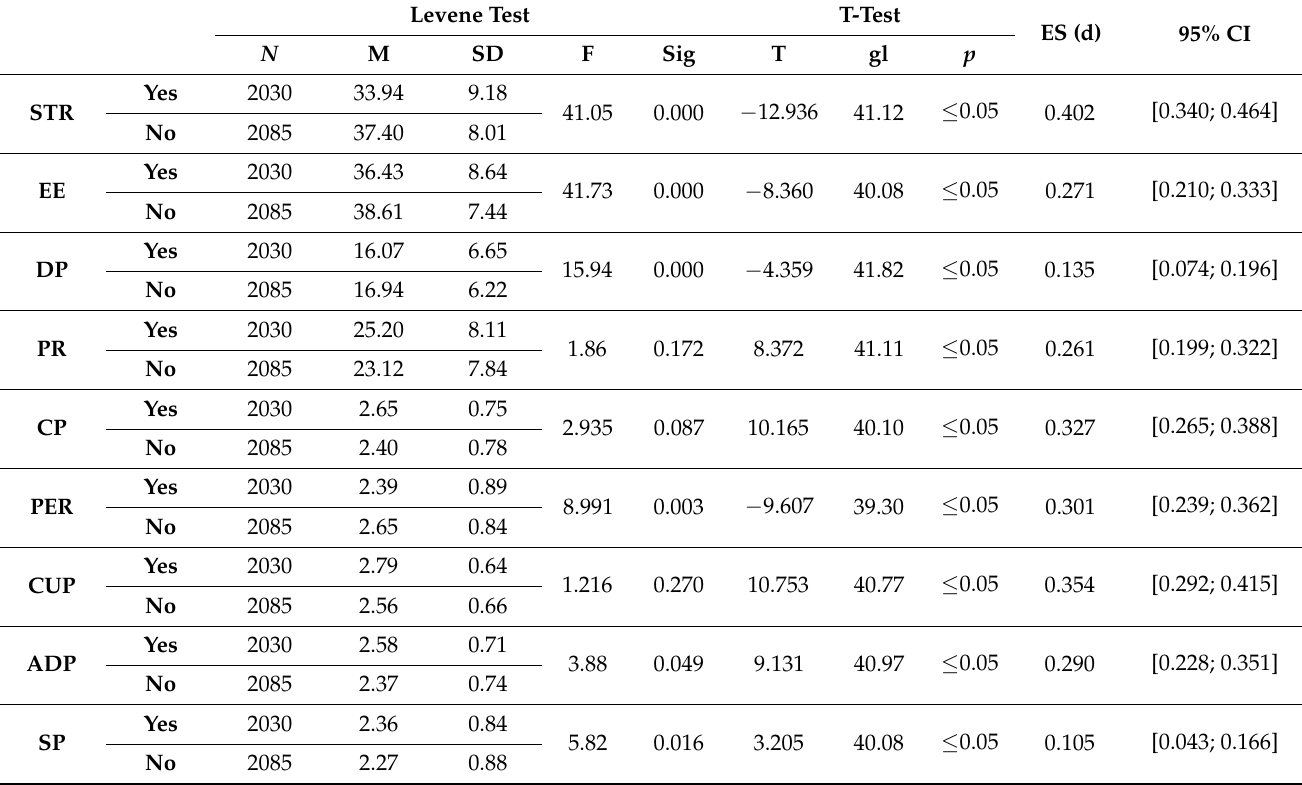
Table 1. Comparative study of the